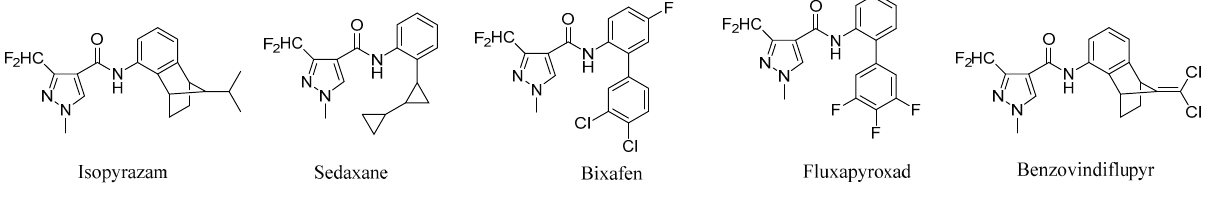
Figure 1. Commercial available 3-(difluoromethyl)-1-methyl-1 H -pyrazole-4-carboxylic acid amide